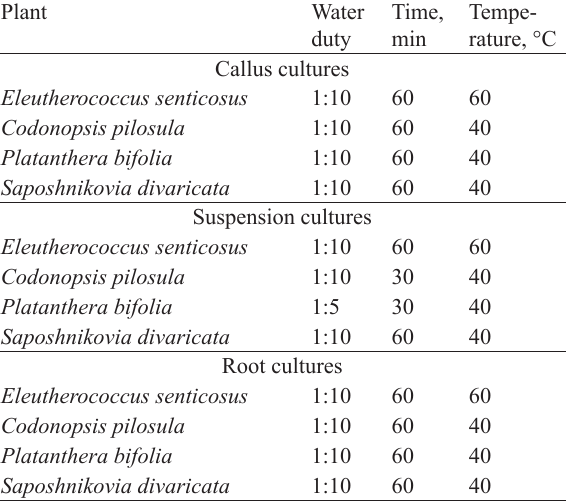
Table 1 Extraction of secondary metabolites from the biomass of callus, cell suspension, and hairy root cultures with